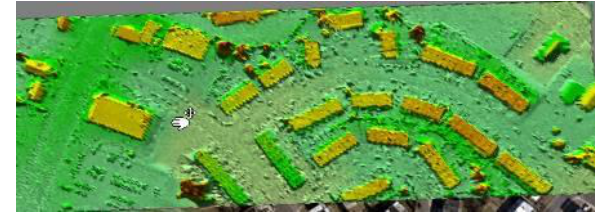
Figure 2. TSR of a point cloud: 3-D objects are very